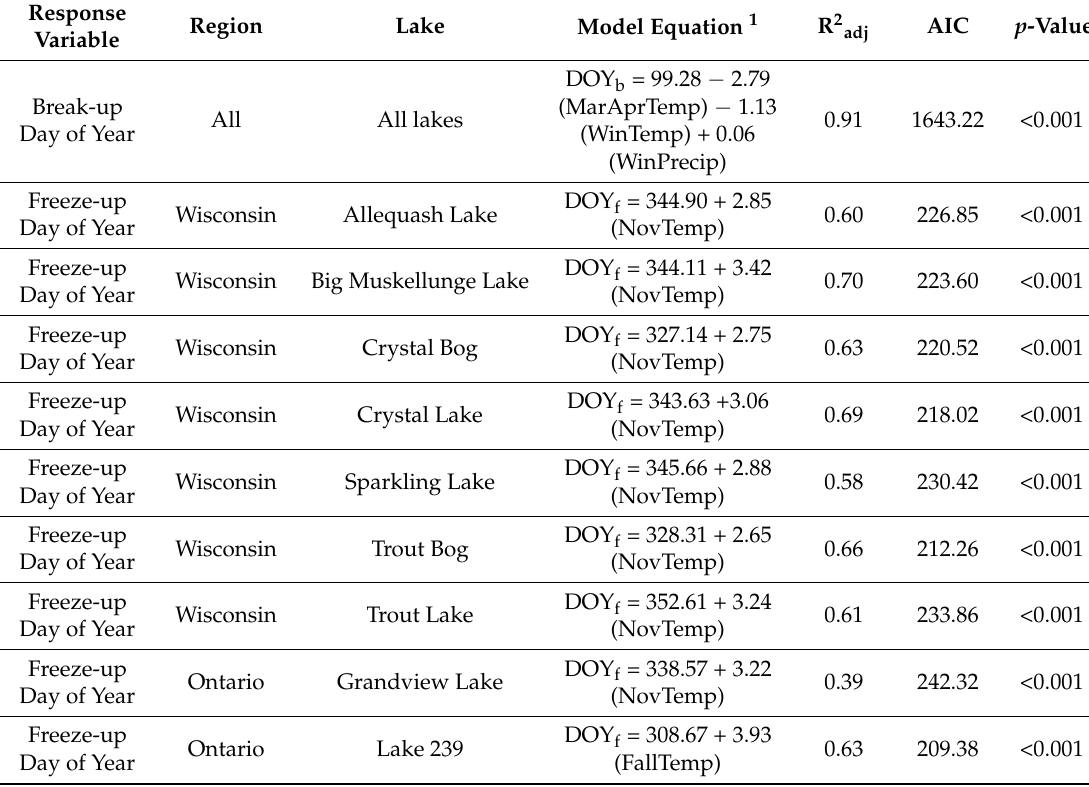
Table 3. Multiple linear regression model results for the timing of lake ice breakup and freeze up. The most parsimonious models with their respective R 2 adj , AIC, and p -values are